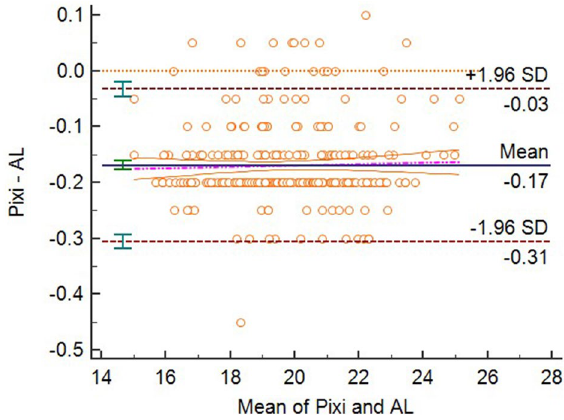
Figure 8. Bland–Altman plot for the agreement of ProPex Pixi and AL